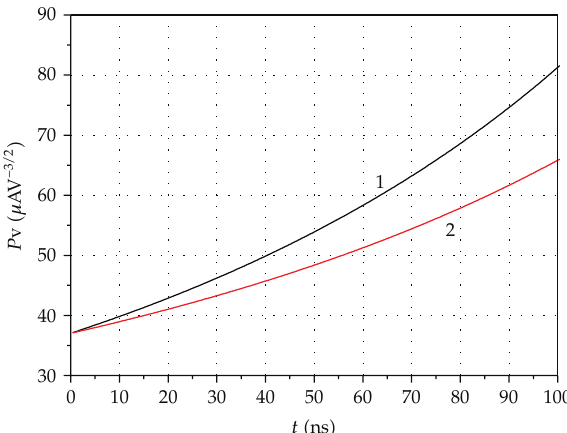
Figure 3: Calculated time-dependent change in perveance of the planar diode, taking into account (cid:2) 1 (cid:3) both the reduction of the A-K gap and increase in cathode area (cid:2) radial plasma expansion (cid:3) ; (cid:2) 2 (cid:3) only the reduction of the A-K gap.